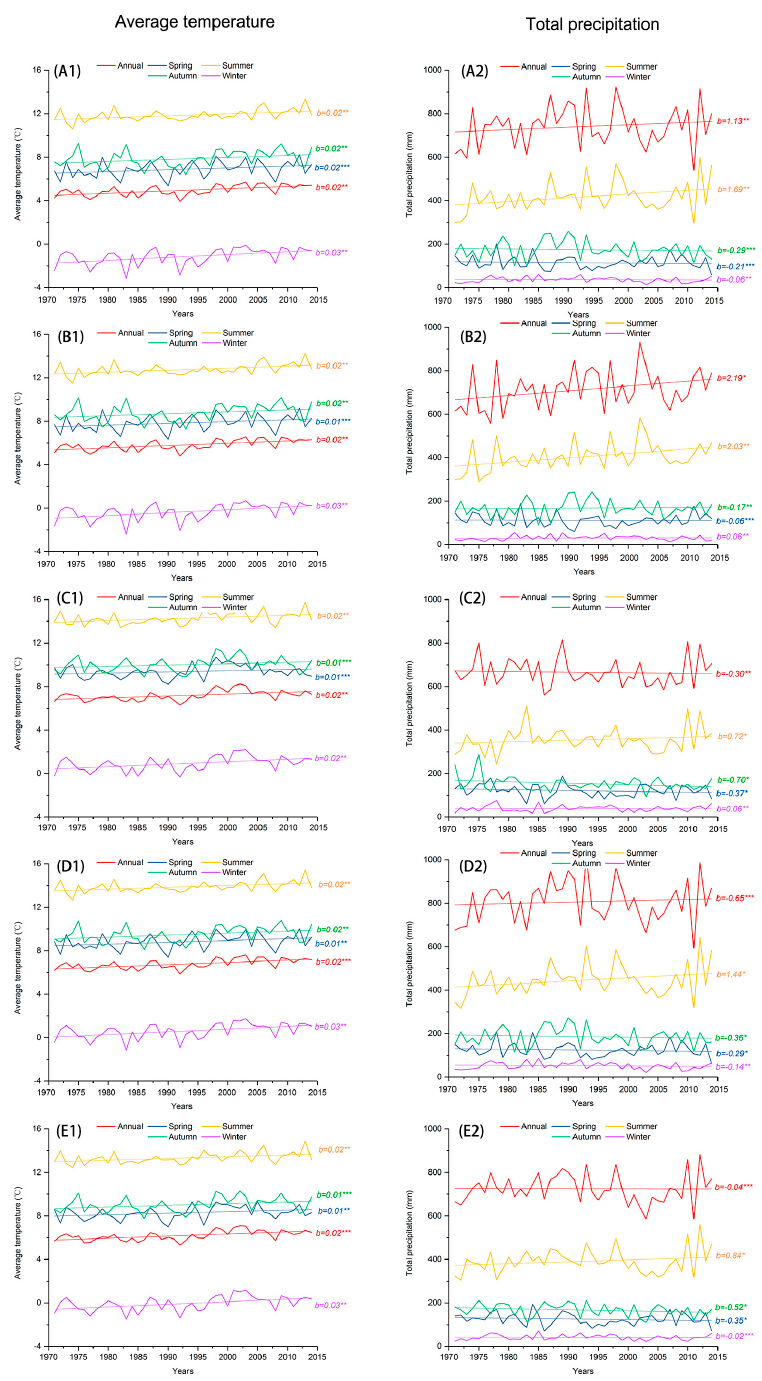
Figure 3. Temperature and precipitation trends in seven sampling site in the alpine treeline ecotone in the eastern Tibetan Plateau during the period of 1971–2014 (( A1 ): temperature of site N1; ( A2 ): precipitation of site N1; ( B1 ): temperature of sites N2 and N3; ( B2 ): precipitation of sites N2 and N3; ( C1 ): temperature of sites N4 and N5; ( C2 ): precipitation of site N4 and N5; ( D1 ): temperature of site S1; ( D2 ): precipitation of site S1; ( E1 ): temperature of site S2; and ( E2 ): precipitation of site S2). Data were acquired from a gridded CRU dataset (Climate Research Unit, 3.23 at 0.5 ◦ spatial resolutions, http://www.cru.uea.ac.uk/data/). Trends of annual and seasonal (spring, summer, autumn, winter) total precipitation, as well as average annual and seasonal temperature are shown here. β is the slope of the trends. * p < 0.05; ** p < 0.01; *** p <